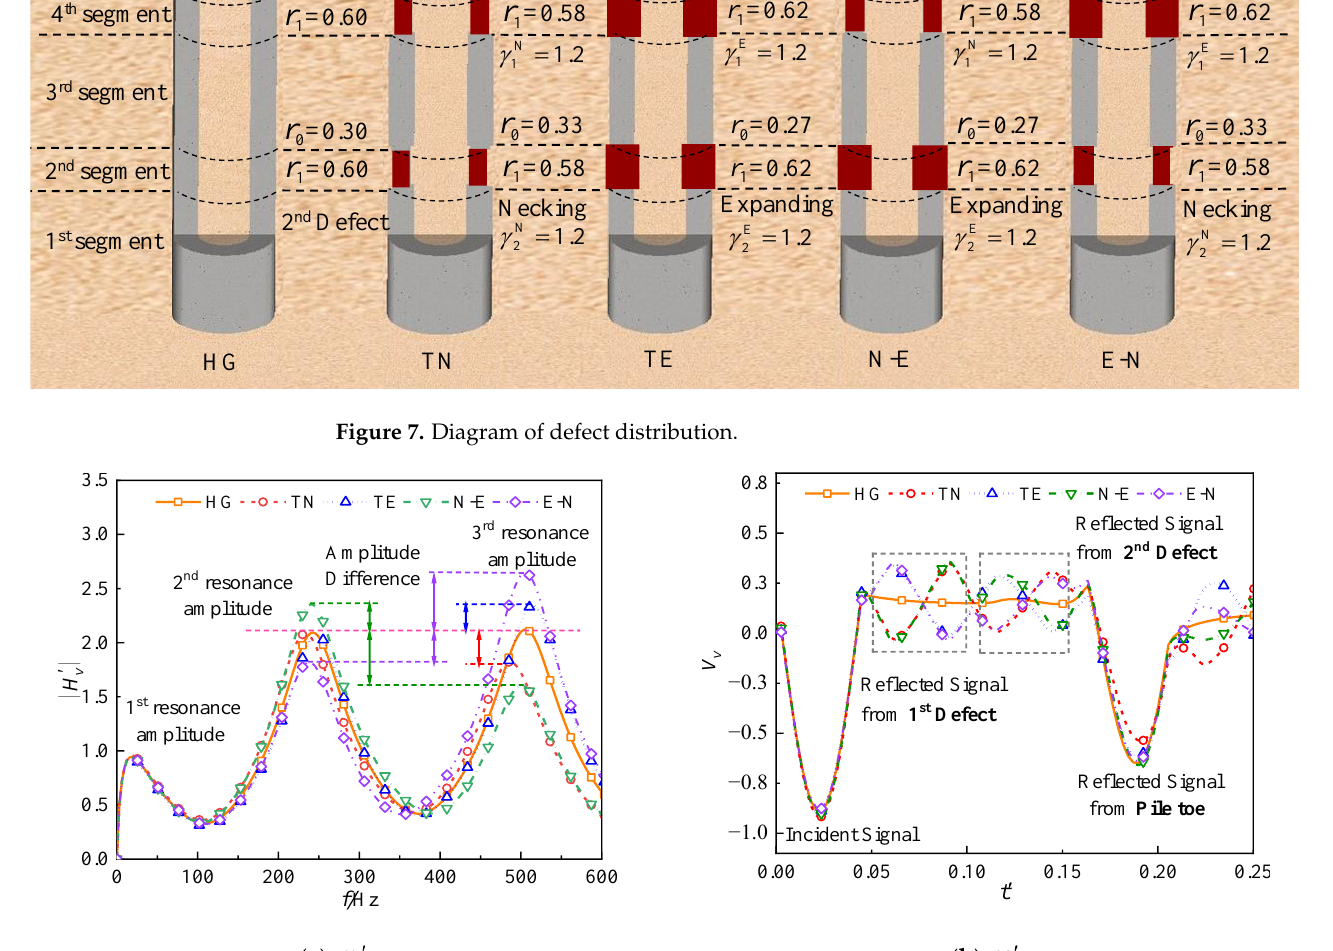
Figure 8. Effect of defect distribution on the pipe pile response. ( a )